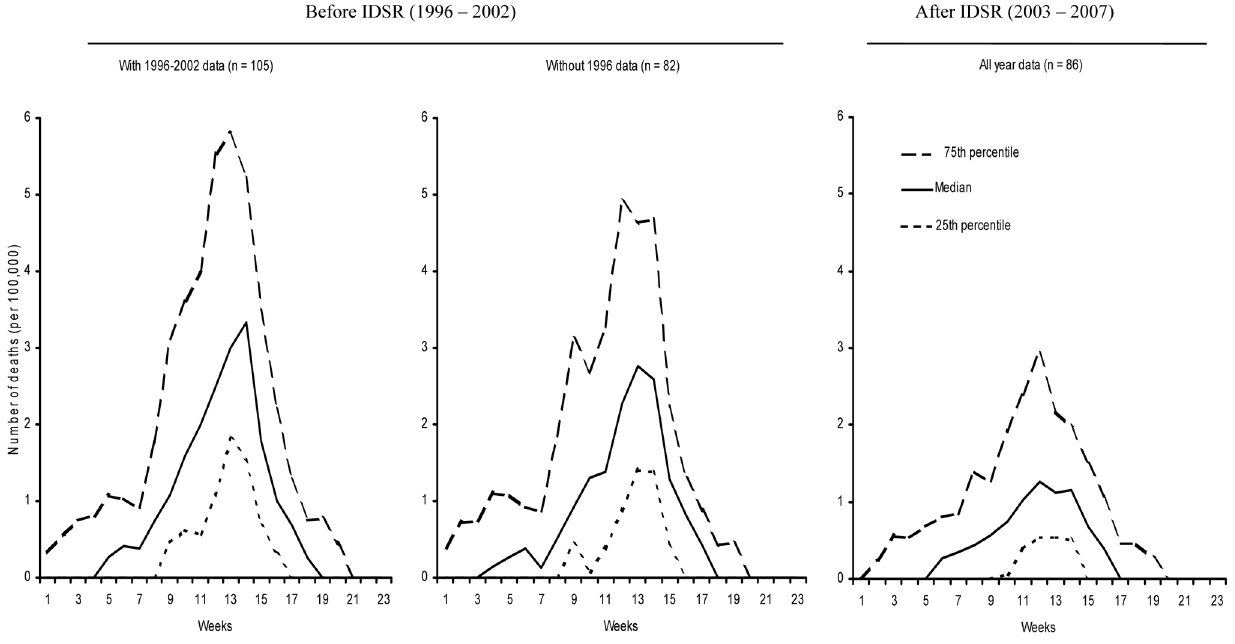
Figure 3. Comparison before (1996–2002) and after (2003–2007) IDSR implementation: weekly median (25 th and 75 th percentiles) of number of meningitis deaths per outbreak. Data source: WHO Multi-Diseases Surveillance Center, Ouagadougou, Burkina Faso. For each weekly mortality rate, we calculated the median, 25 th and 75 th percentile of the 105 and 82 outbreaks before IDSR and 86 outbreaks after IDSR. Before IDSR, the median (25 th and 75 th percentile) cumulative number of deaths per outbreak was 23.8 (17.9 and 35.9) per 100,000 inhabitants when 1996 data were included and was 20.5 (16.1 and 30.3) per 100,000 inhabitants when 1996 data were excluded. After IDSR, the median (25 th and 75 th percentile) cumulative number of deaths per outbreak was 12.6 (8.8 and 21.3) per 100,000 inhabitants.